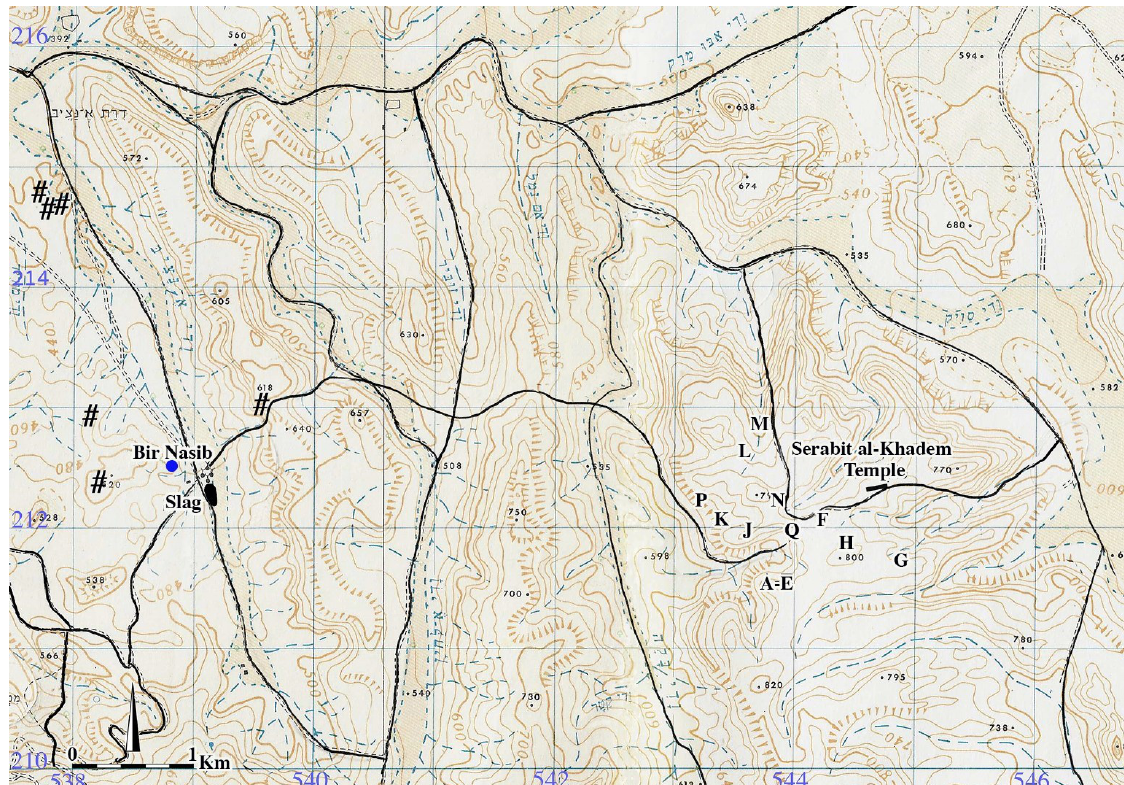
Figure 3 UTM map of Serabit al-Khadem and Wadi Nasib area, showing the main ancient trails, the location of the temple, the turquoise mines (F-N), Egyptian rock stela and inscriptions (A- E), and rock shrine (Q) after Petrie (1906, 55). Dark spot next to Bir Nasib: the copper slag pile and #- furnace batteries, after Tallet’s maps (2011, 80, 85; 2012, 153), which show many more mines, copper production sites, and